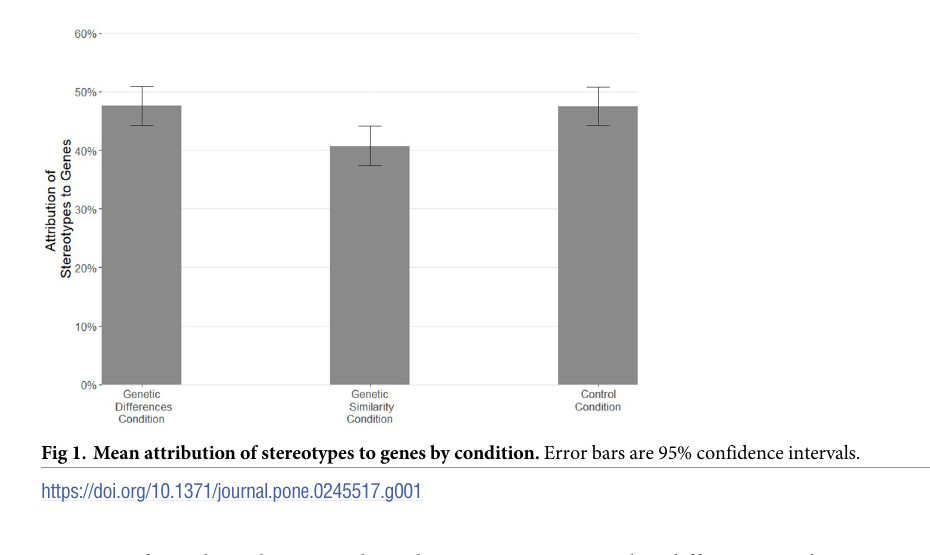
Table 1. Correlations between perceived accuracy of stereotypes, attribution of stereotypes to genes, environment, genetic essentialism, and social dominance orientation.